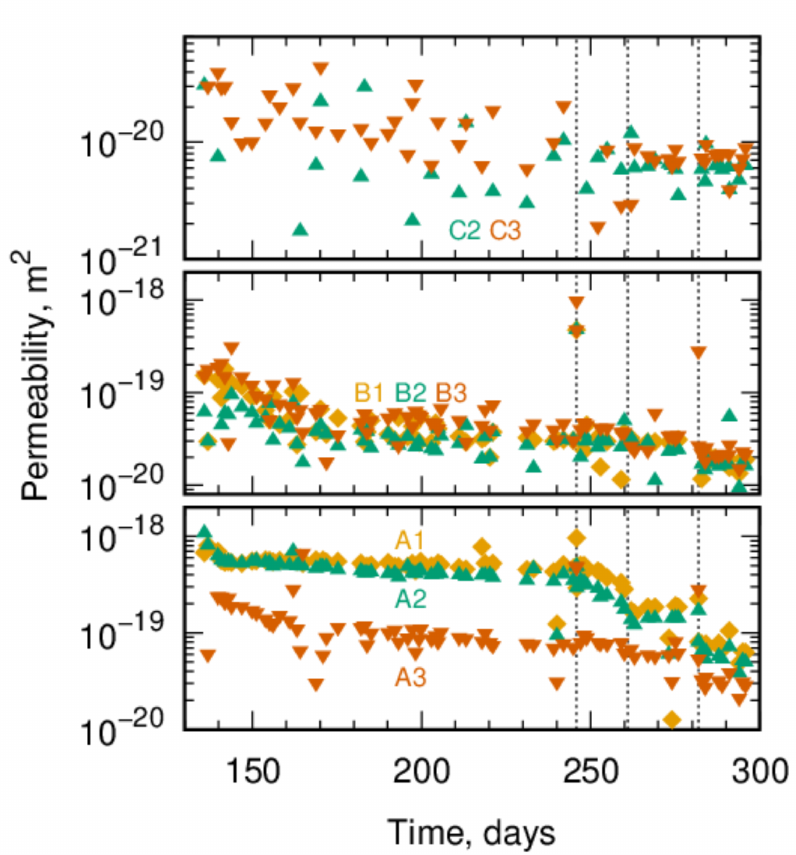
Figure 7. Permeability (m 2 ) of 10X specimens compacted to dry densities of 1.4 g/cm 3 (A1–A3); 1.6 g/cm 3 (B1–B3); 1.8 g/cm 3 (C2, C3), and permeated by SGW. Vertical dotted lines mark